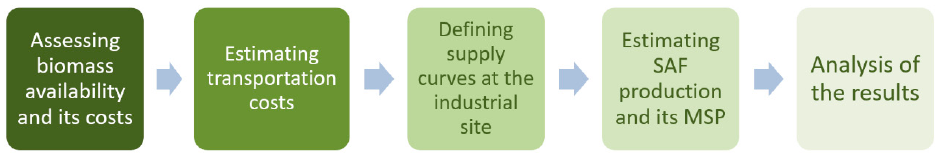
Figure 2. Scheme of the methodological procedure applied to assess SAF production in Brazil.